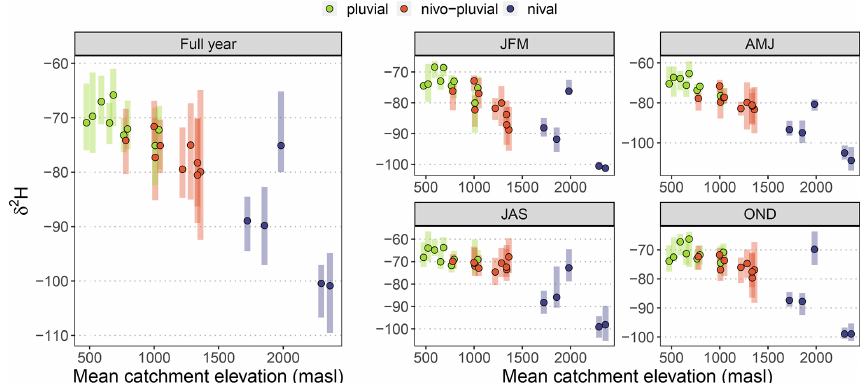
Figure 6. Median and ranges (10th and 90th percentile) of δ 18 O for the full sampling period (left) and separately for the seasons (right) of the samples for each catchment against the mean catchment elevation. The colours indicate the regime type to which the catchments were assigned.